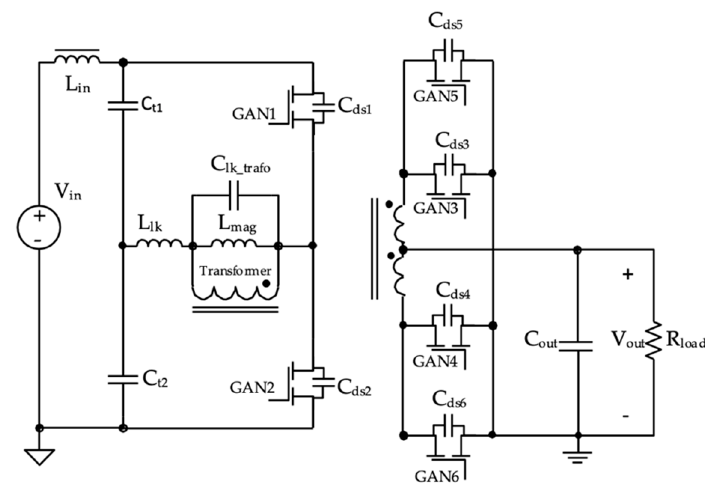
Figure 2. Simplified schematic of a zero-current and zero-voltage switching (ZVZCS) current-fed half-bridge converter considering the main parasitic elements.